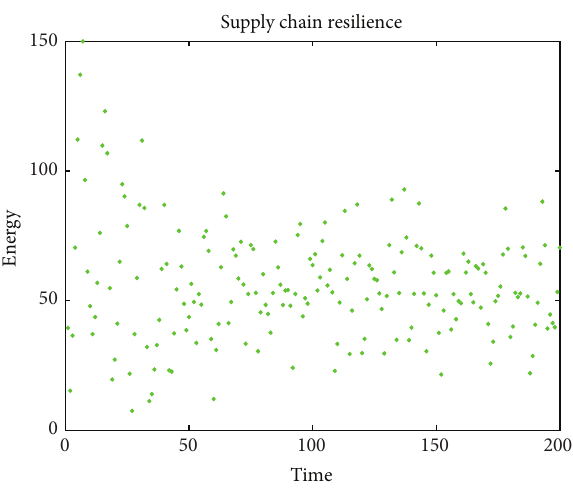
Figure 12: There is no resilience at SOC/number 1.